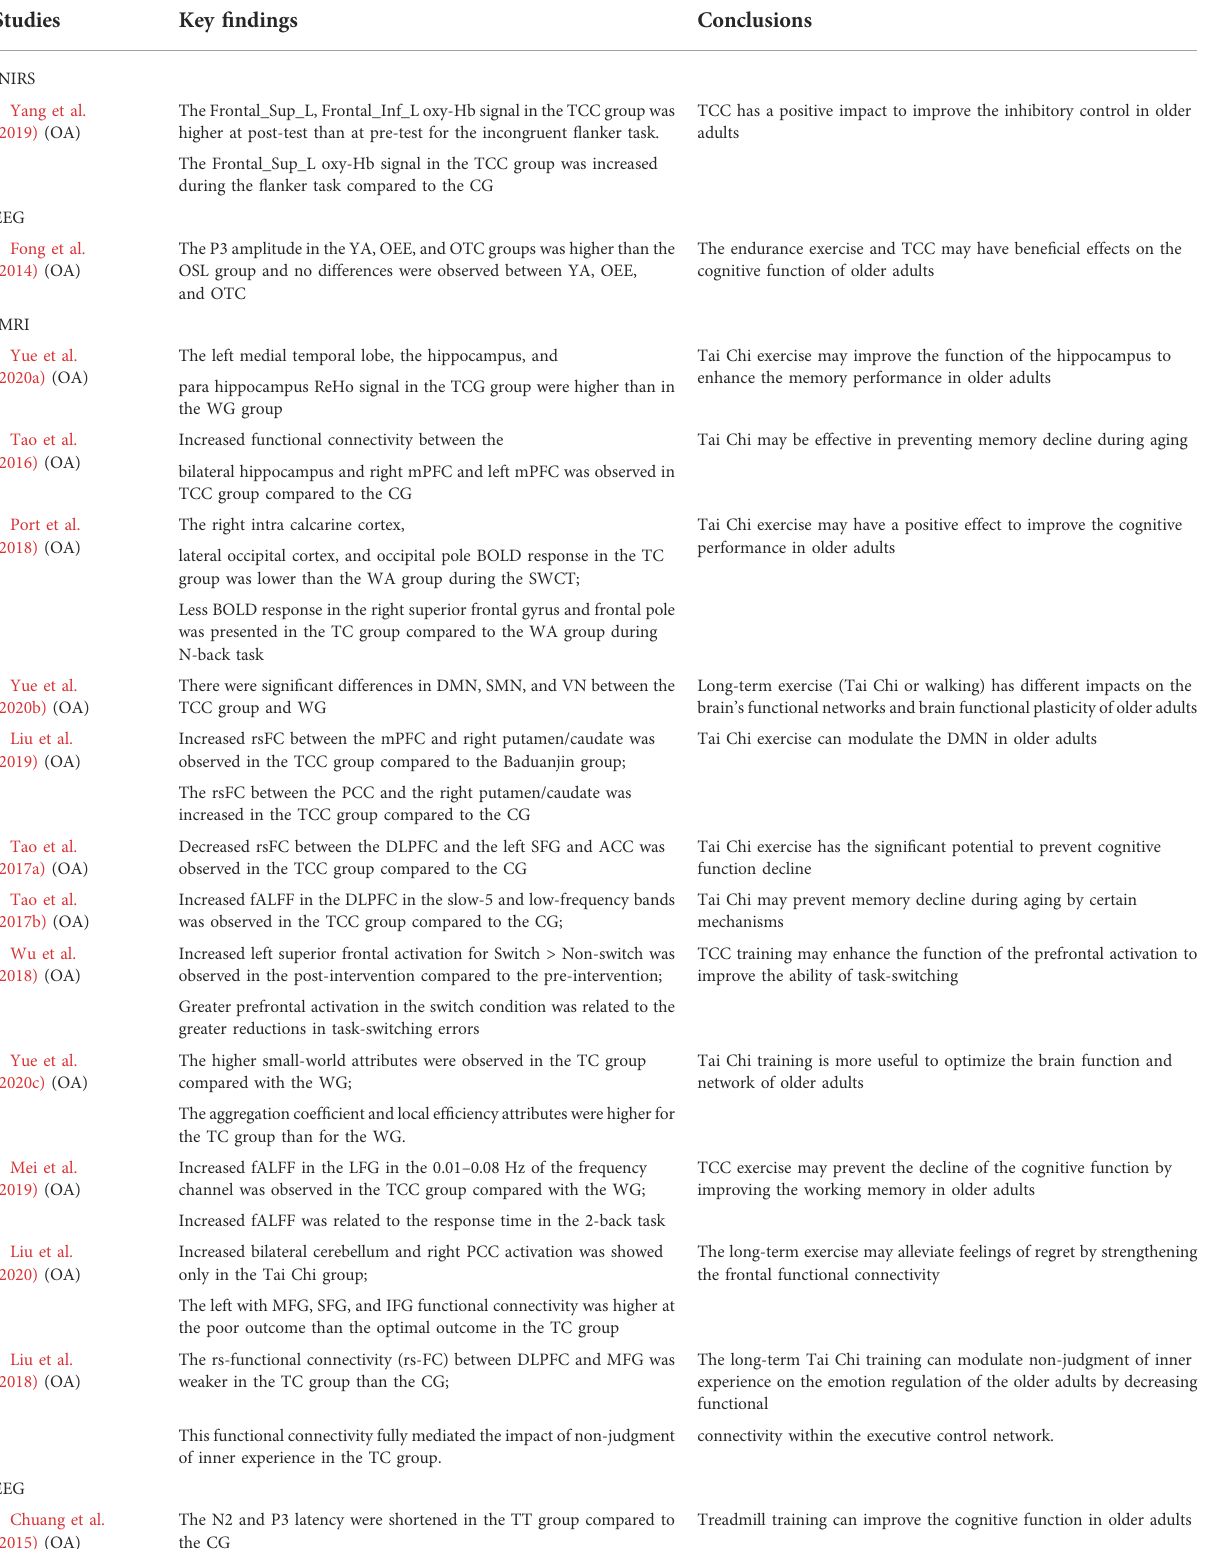
TABLE 5 Key fi ndings and conclusions of the studies in healthy older adults. Studies Key fi ndings